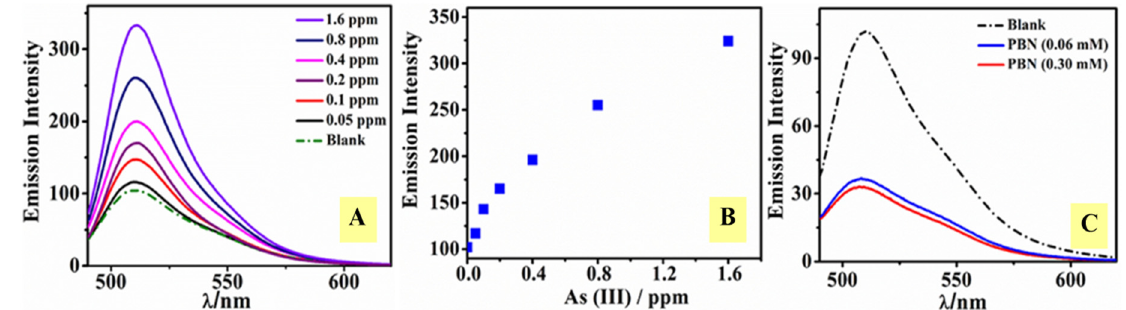
Figure 5. Fluorescence emission spectra of Flo (blank) in the presence of different As(III) concentrations from 0.05 ppm to 1.6 ppm ( A ). Plot of fluorescence intensity of Flo (0.2 mM) after exposure to a variable concentration (0.05–1.6 ppm) of As(III) ( B ). Effect of PBN addition (0.06 mM, 0.3 mM) over Flo (0.2 mM) fluorescence ( C ).